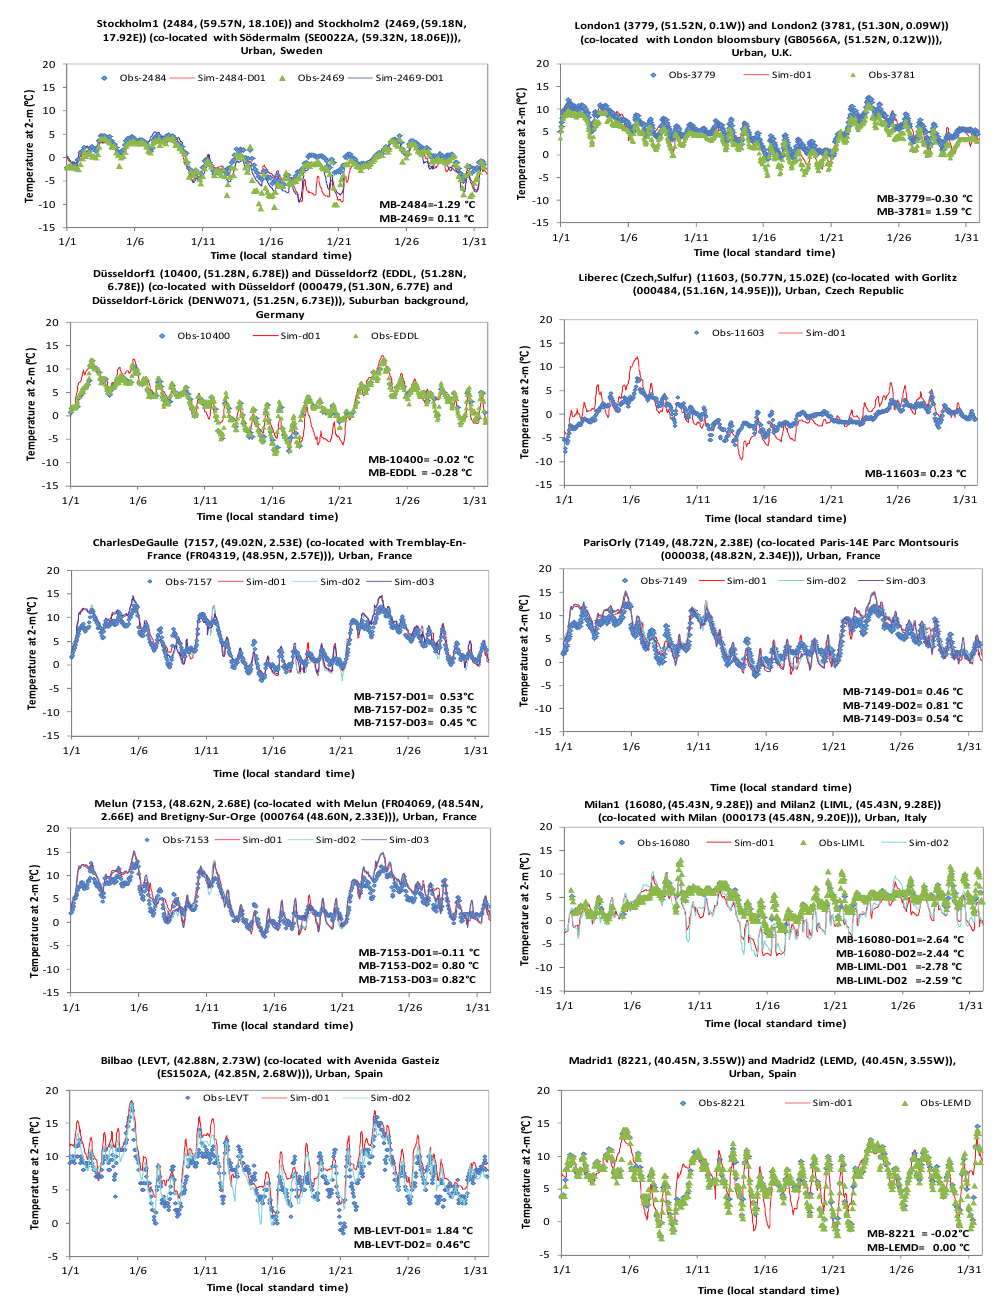
Figure 8. Simulated and observed 2-m temperatures in January 2001 at selected sites. Fig. 8. Simulated and observed 2m temperatures in January 2001 at selected